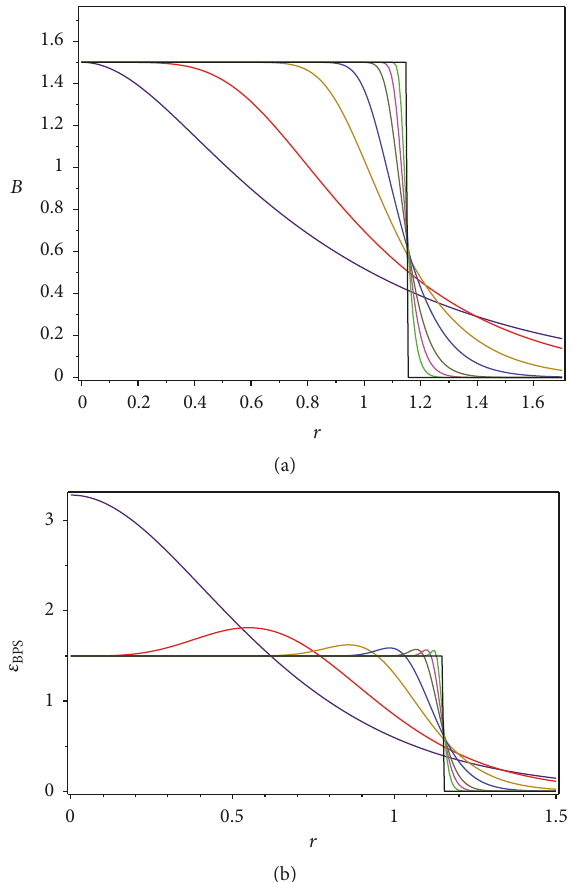
Figure 4: The magnetic field 𝐵(𝑟) (a) and the BPS energy density 𝜀 BPS (𝑟) (b) come from the generalized Born-Infeld-Higgs model (43) with 𝐺(𝑔) = 1 and 𝜔(𝑔) = 𝜆𝑔 2𝜆−2 . Observe that 𝜆 = 1 (indigo lines) represents the usual BIH model and the true compacton solution is given by 𝜆 = ∞ (black lines). The convention for the color of the lines is the same given in Figure